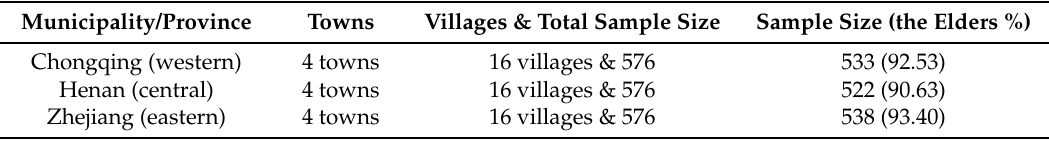
Table 1. Sampling strategy and valid sample size by area.